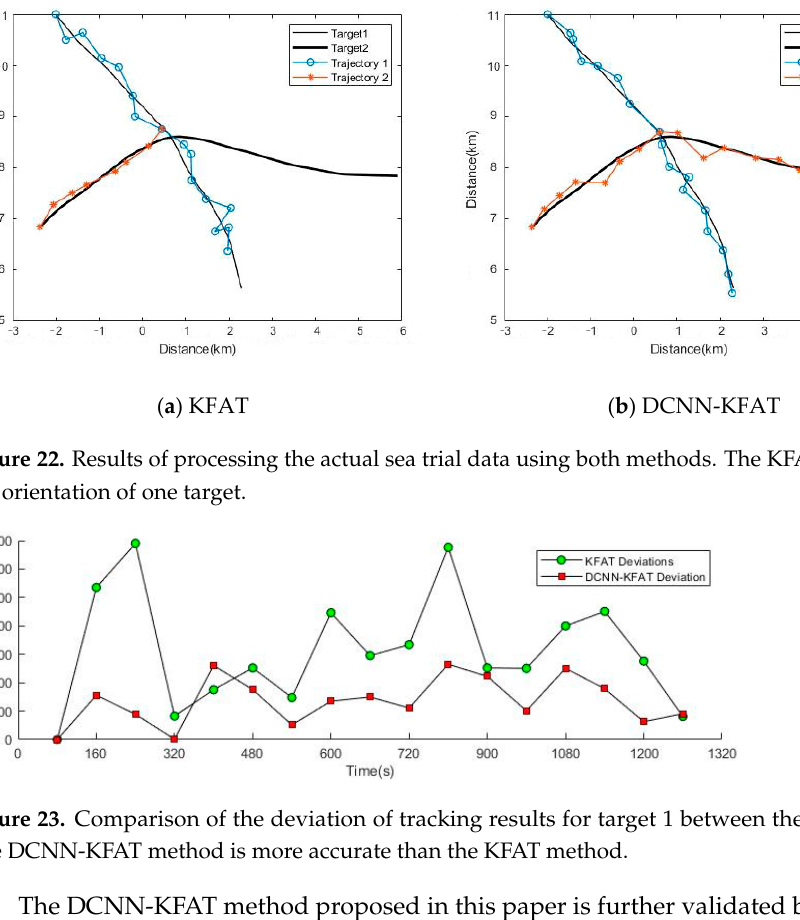
Figure 21. Data set of target echo signals, obtained after processing according to the method in Section 2.1, containing the time-frequency spectrograms of the echo signals of two different targets.